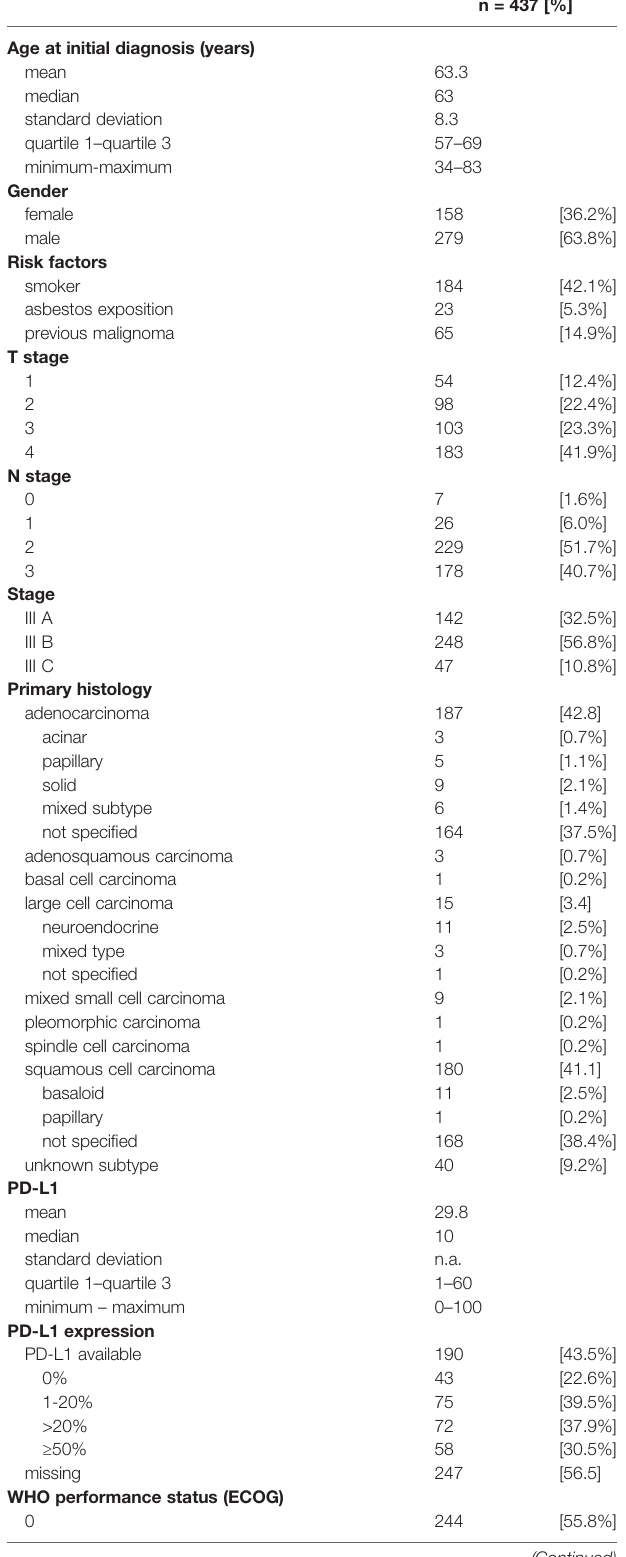
TABLE 1 | Patient baseline